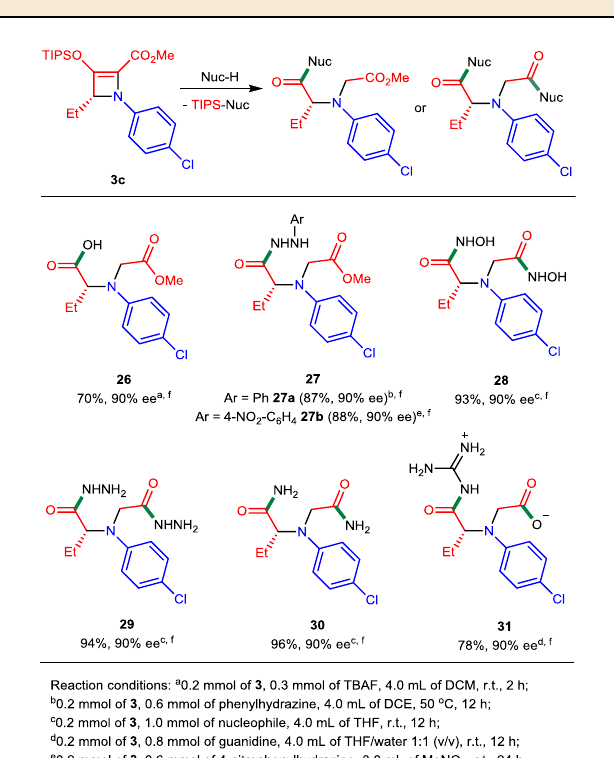
Table 5 Ring-opening reactions of 2-azetine-2-carboxylate 3c with other